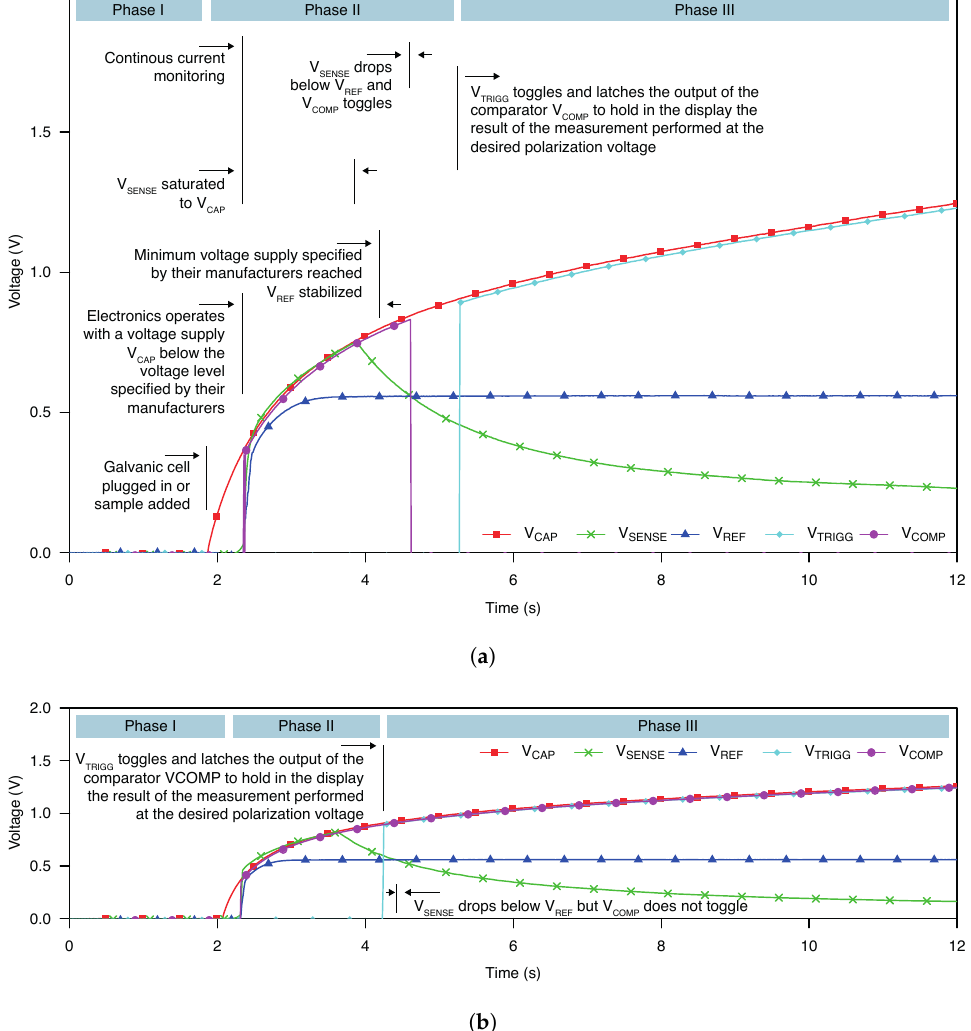
Figure 5. ( a ) Transient waveforms of the signals involved during the measurement of a sample concentration below the threshold concentration using the implemented self-powered point-of-care device. ( b ) Transient waveforms of the signals involved during the measurement of a sample concen- tration above the threshold concentration using the implemented self-powered point-of-care device.